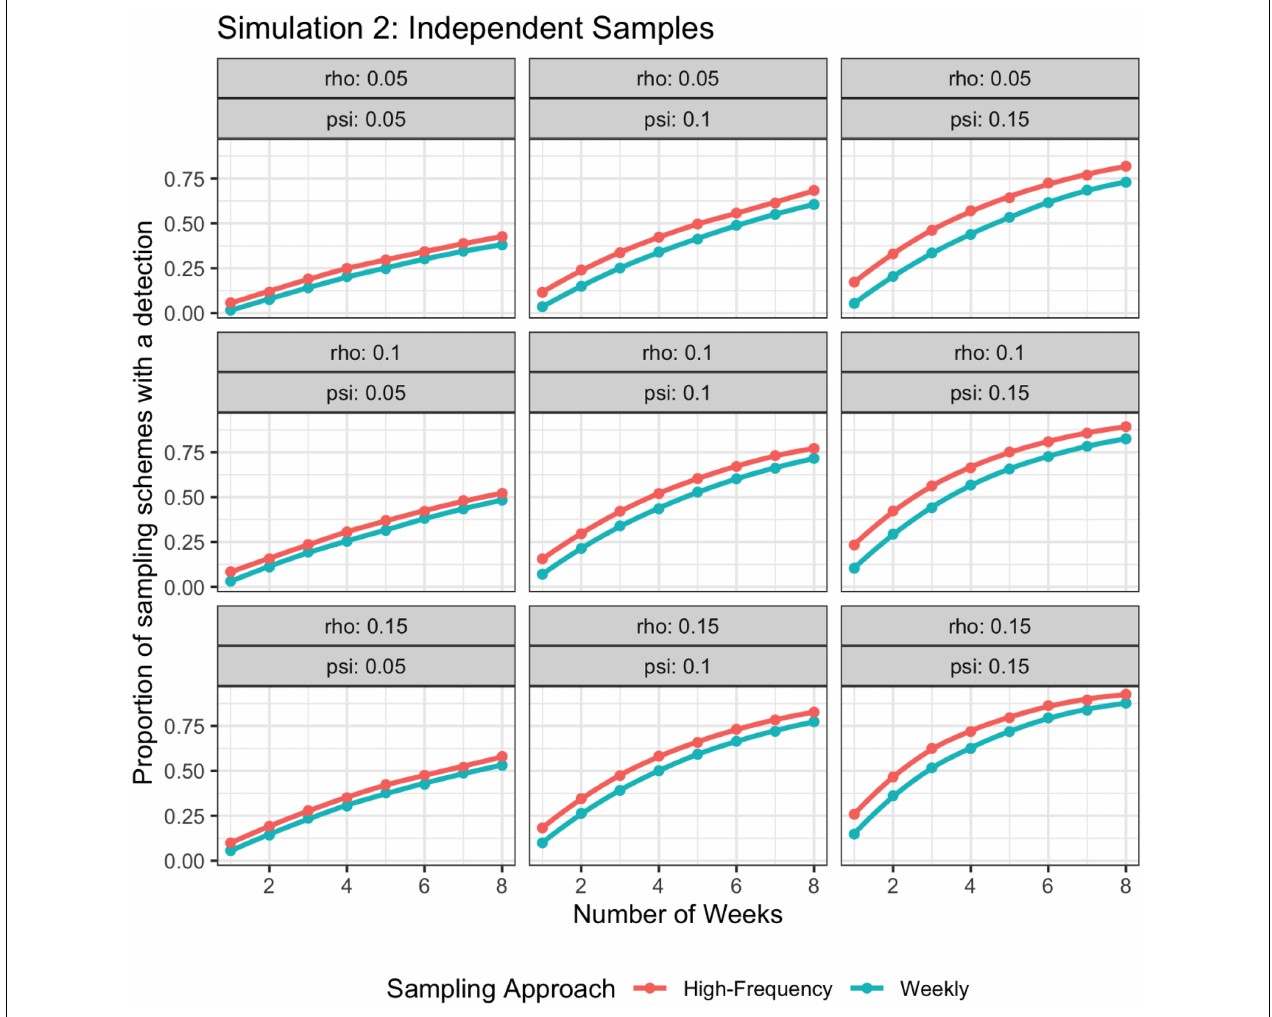
FIGURE 7 | Probability of detection as a function of rho , psi , and number of weeks; rho varies stochastically on a day-to-day basis. The high-frequency approach collects samples daily and the weekly approach takes seven samples once a week. Weekly samples are modeled as independent